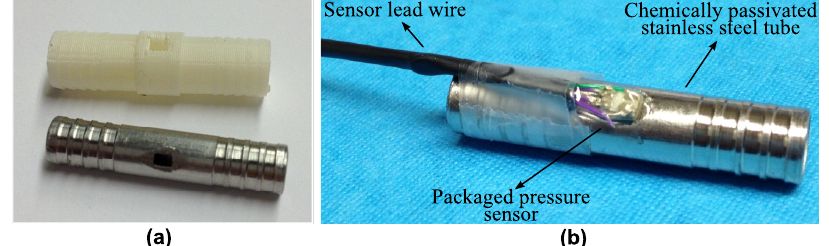
Figure 4. ( a ) Connector tubes used for testing purposes; ( b ) pressure sensor integrated in a stainless steel